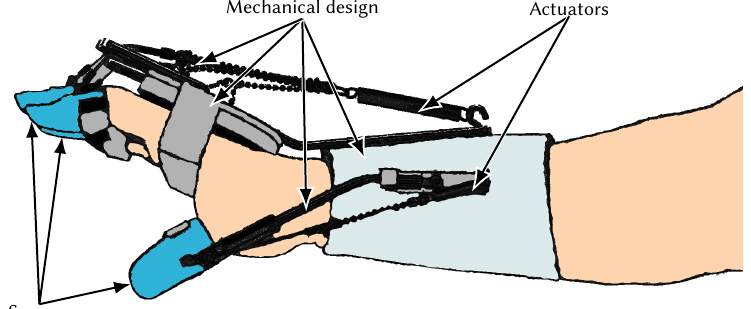
Figure 2. Components of a bionic orthosis - adapted with permission from Saebo, 2020